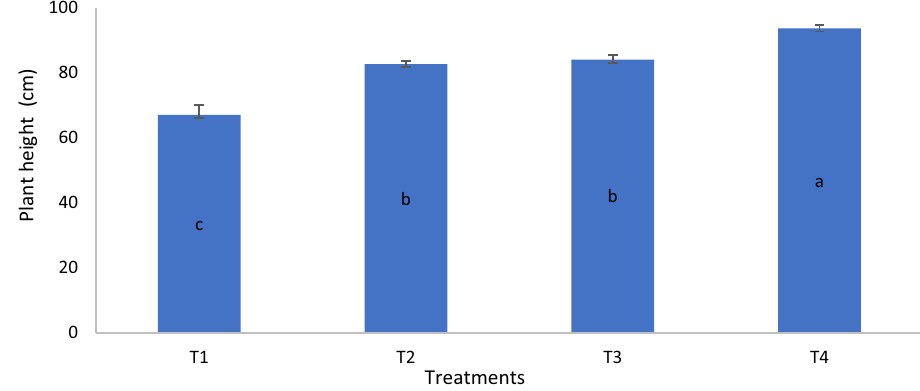
Figure 6. Chicken litter biochar on height of MR219 rice plants cultivated on a tropical acid soil.